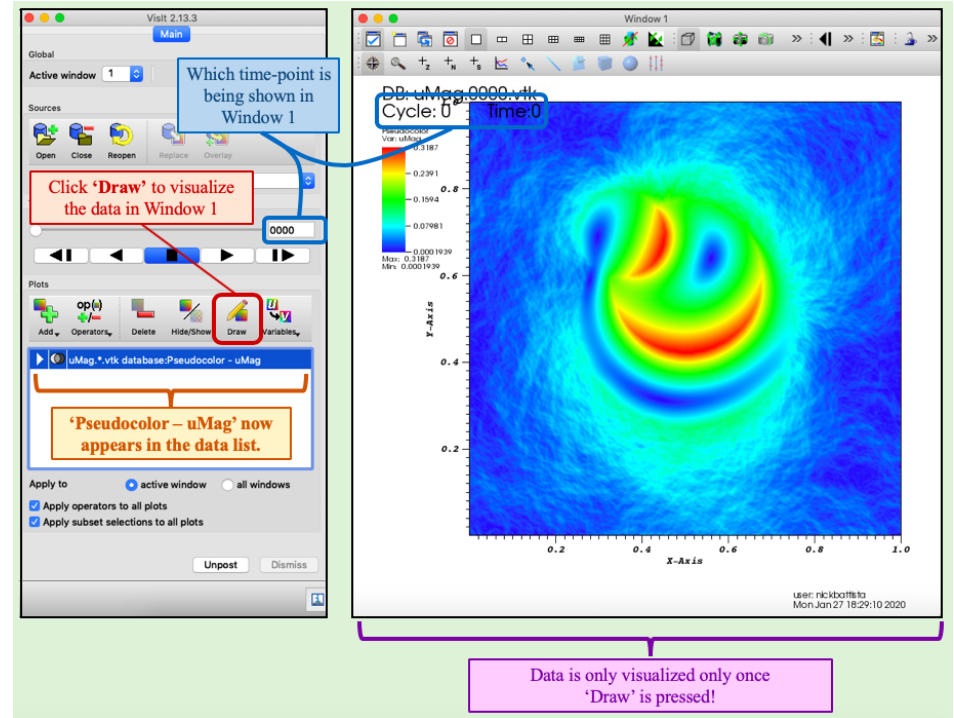
Figure 11. ‘Drawing’ the data in VisIt. The data shown in Window 1 here corresponds to time-point 0, as given from the time slider